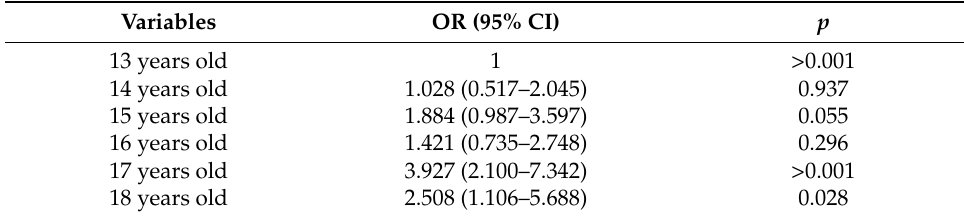
Table 6. Backward stepwise binary logistic